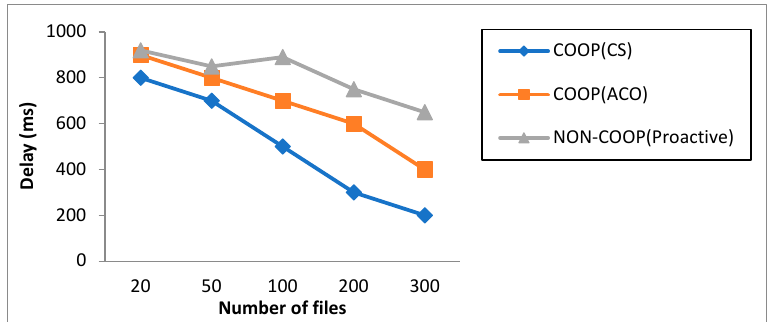
Figure 11. Delay with increasing number of files.